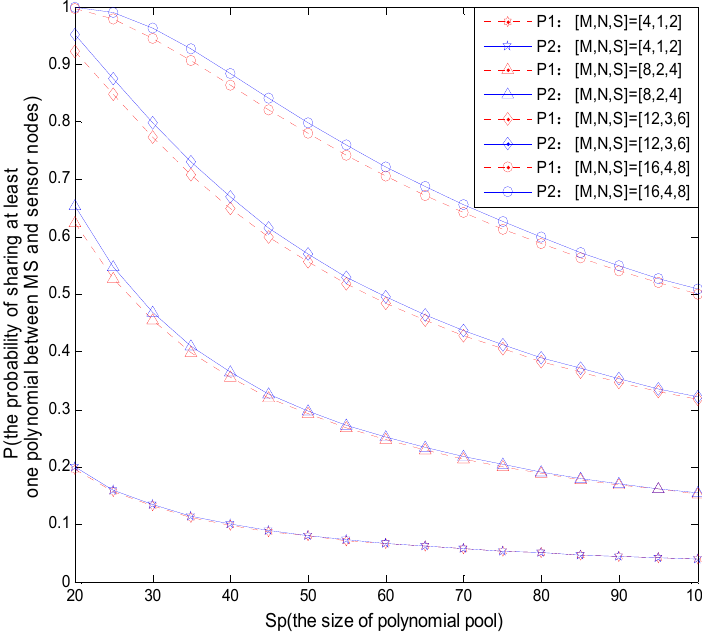
Figure 5. The probability of sharing polynomial with different S p .